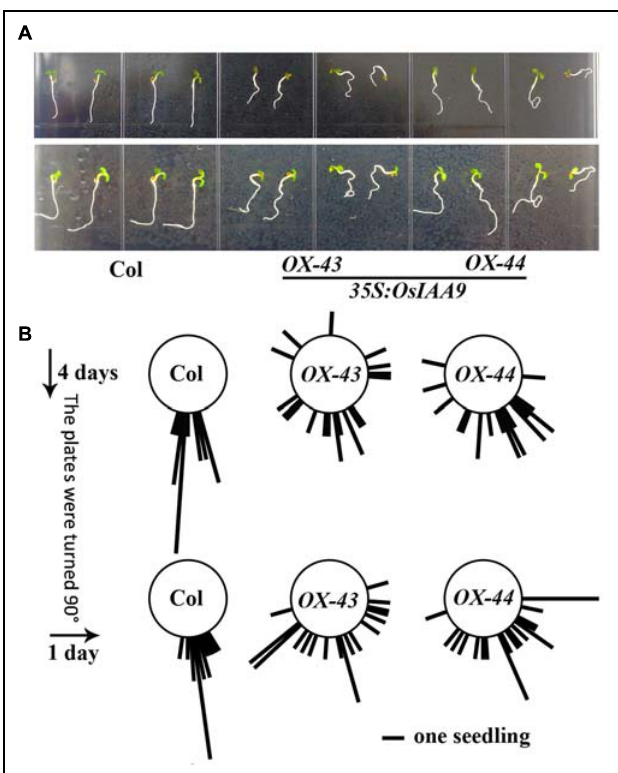
FIGURE 6 | Expression of OsIAA9 in Arabidopsis affects root gravitropic response. (A) Response of Col wild type (left) and OsIAA9 transgenic seedlings (middle and right) to a directional change of gravity. Up panel: before the plates were turned, low panel: 1 day after the plates were turned. Seedlings were grown on vertically plates for 4 days, and then the plates were turned 90 0 and kept for 1 days. (B) Quantification of response of Col wild type and OsIAA9 transgenic plant seedlings to a directional change of gravity. The angle between the gravity vector and the root were measured when the seedlings were grown vertically for 4 days and 1 day after the plates were turn 90 0 . Bar represents one seedling.